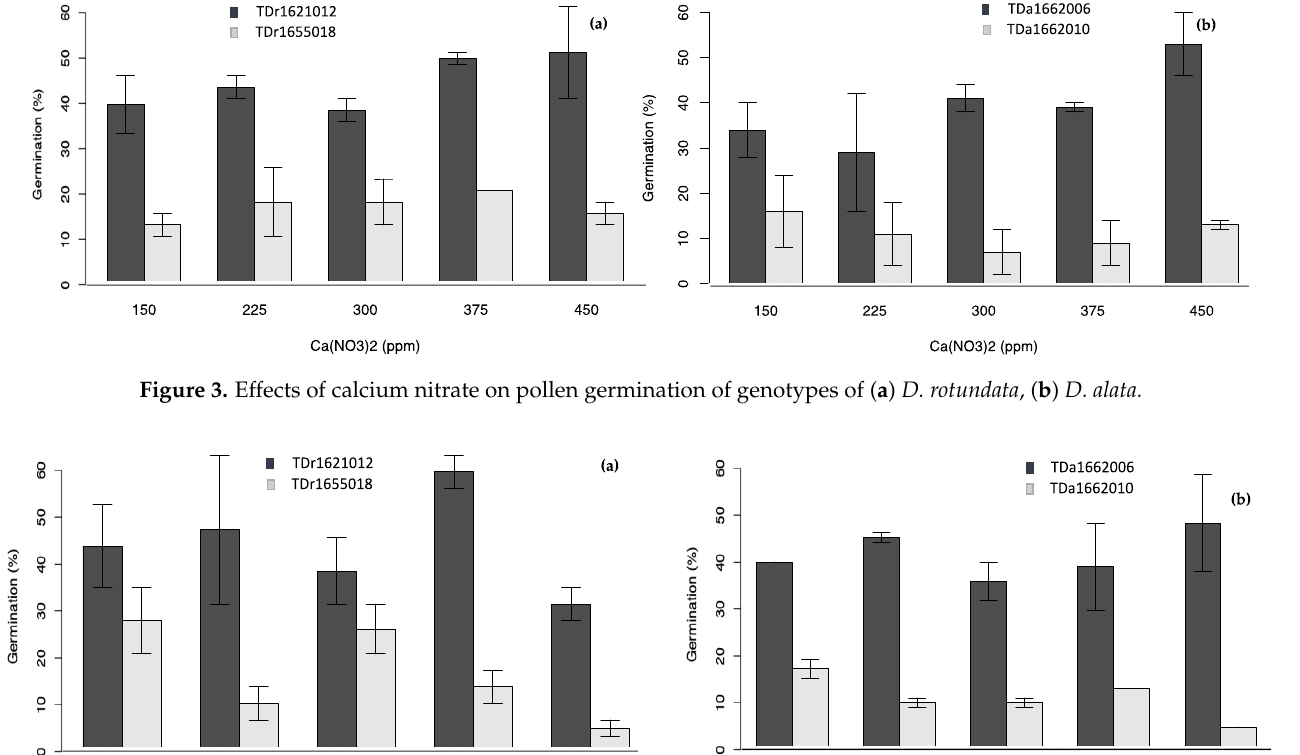
Figure 5. Effects of the medium pH on pollen germination of genotypes of ( a ) D. rotundata , ( b ) D. alata. 2.3. Effects of Polyethylene Glycol on Yam Pollen Germination The best single- factor experiments’ composition media were selected to evaluate the effects of polyethylene glycol (PEG) on percent yam pollen germination. For D. rotundata , the medium composition at this stage was: 12.5% sucrose, 125 ppm boric acid, 375 ppm calcium nitrate, and adjusted at pH 6.5. On the other hand, the medium composition for D. alata was made of: 5% sucrose, 100 ppm boric acid, 450 ppm calcium nitrate, and ad- justed at pH 7. All other medium ingredients (MgSO 4 .7H 2 O and KNO 3 ) not optimized in this study were kept at the same concentrations as in the Brewbaker and Kwack (BK) me- dium [12]. At this stage, 0.5% agar, 25 °C and the incubation duration of 3 h were used for both species. The incorporation of PEG in the optimized medium as well as the interaction geno- type × PEG had no significant effects on D. rotundata pollen germination percent (Table 3). However, significant effects of the genotype ( p = 0.004), PEG application ( p = 0.02) and the interaction PEG × genotype ( p = 0.04) were recorded for D. alata . The presence of PEG in the medium significantly reduced D. alata pollen germination ability by 67 – 75% (Table 3).